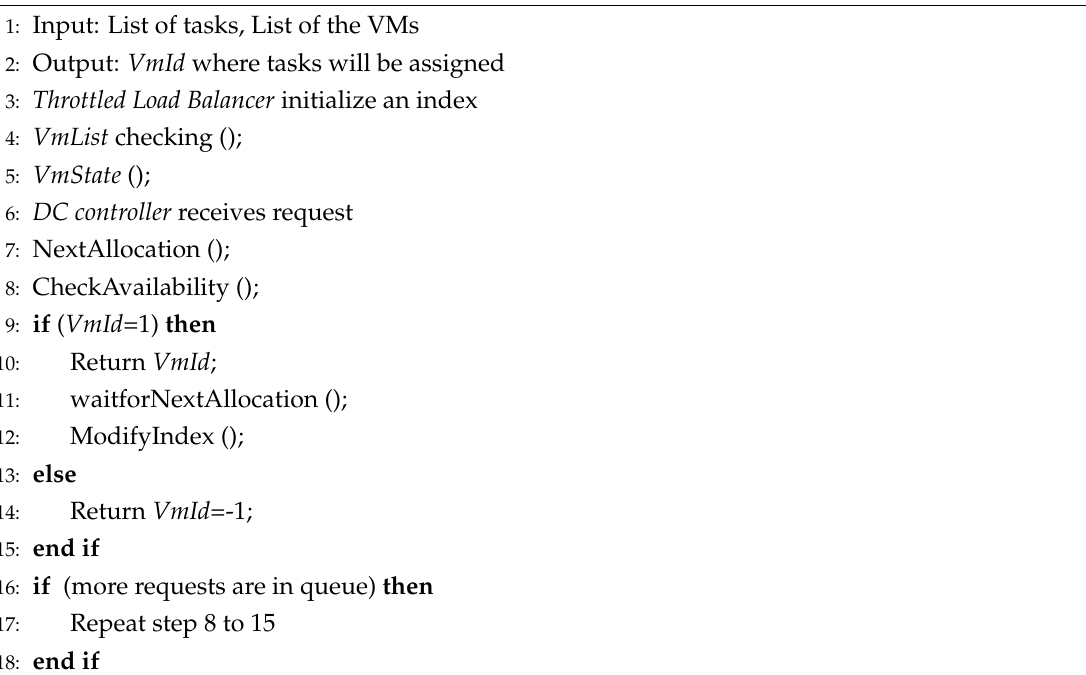
Algorithm 2 Throttled-based resource